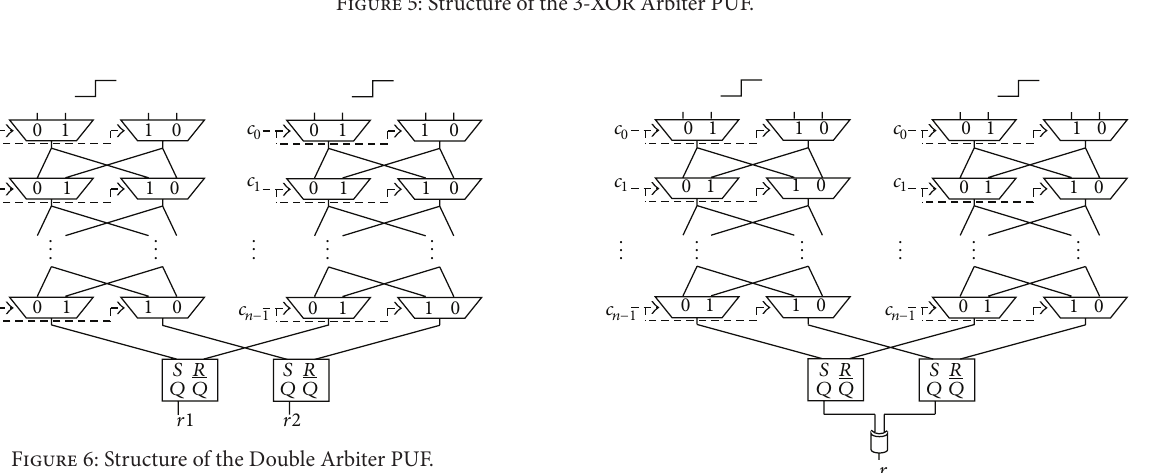
Figure 5: Structure of the 3-XOR Arbiter PUF.